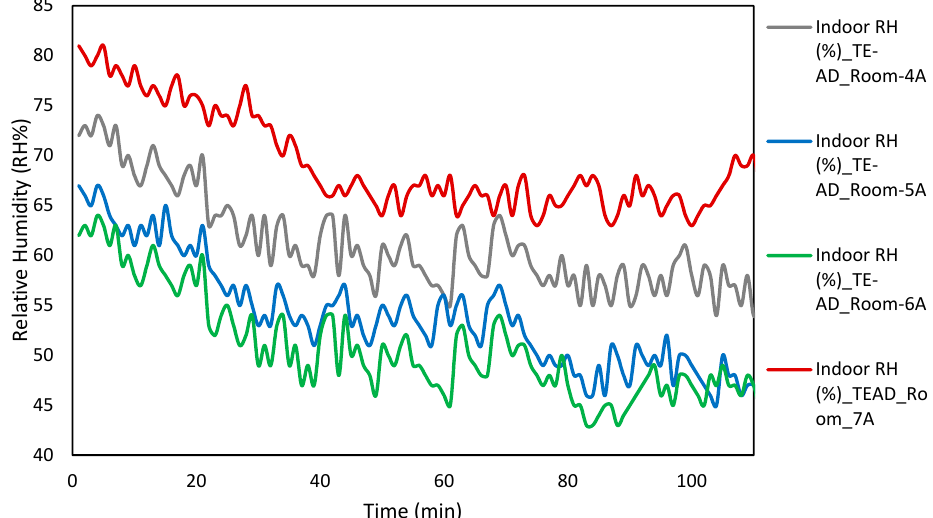
Figure 4. Changes in indoor and outdoor relative humidity at different study power inputs.